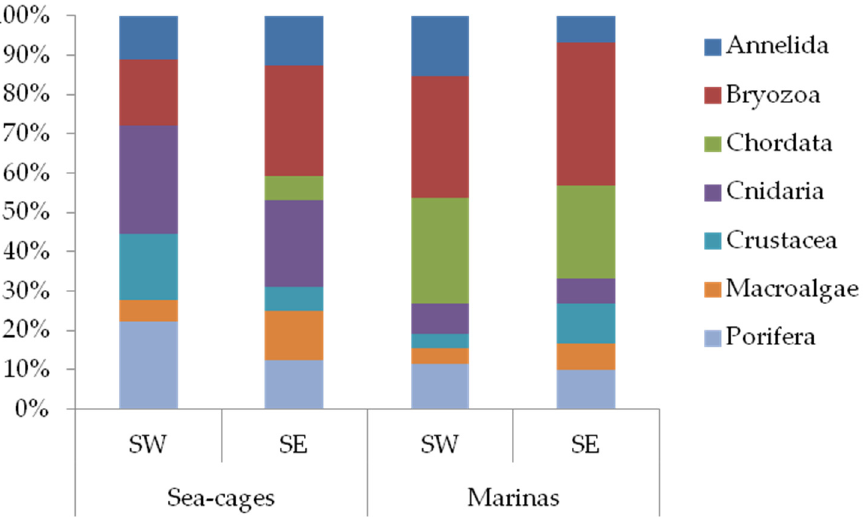
Figure 2. Taxa contributions for similarity among plates (SIMPER, 100% stacked column, n = 6) in 3-month-old experimental plates for each type of artificial environment (sea-cages vs. marinas) and region (SW vs. SE).